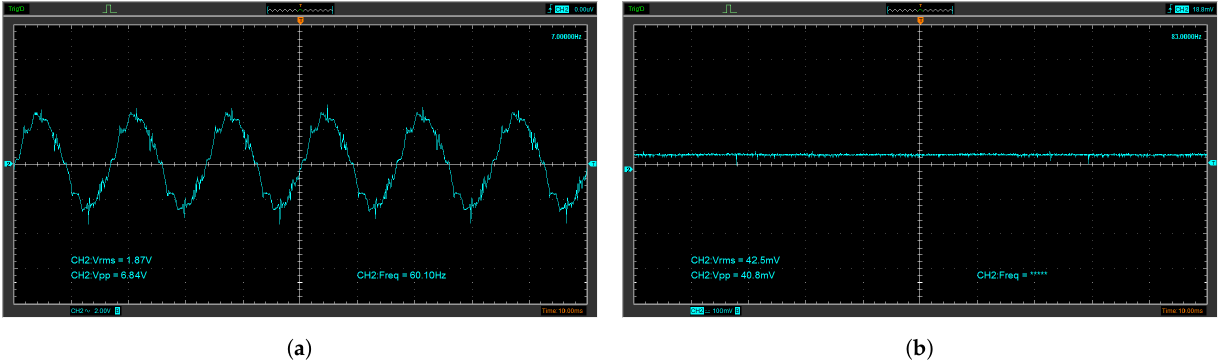
Figure 14. The current waveform of the induction stove in standby mode. ( a ) At AC. ( b ) At DCHN.